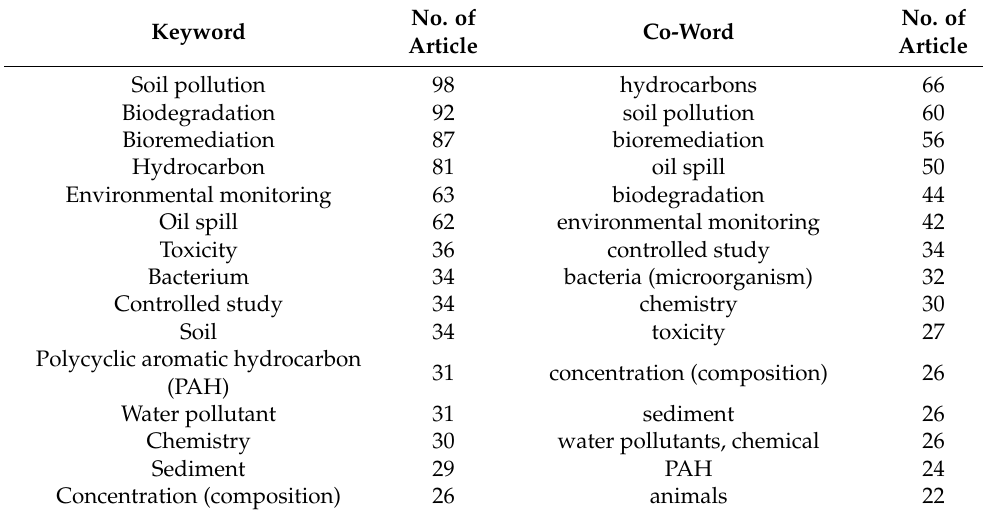
Table 2. Descriptive analysis: top 15 most frequent keywords and co-words in descending